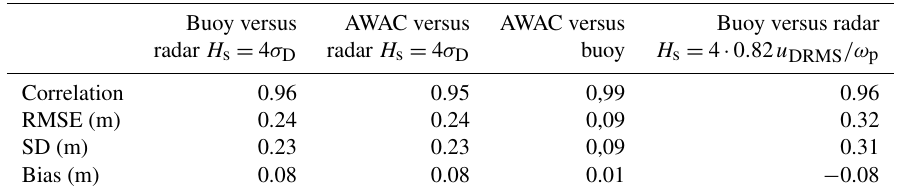
Table 1. Main statistical parameters resulting from comparisons.